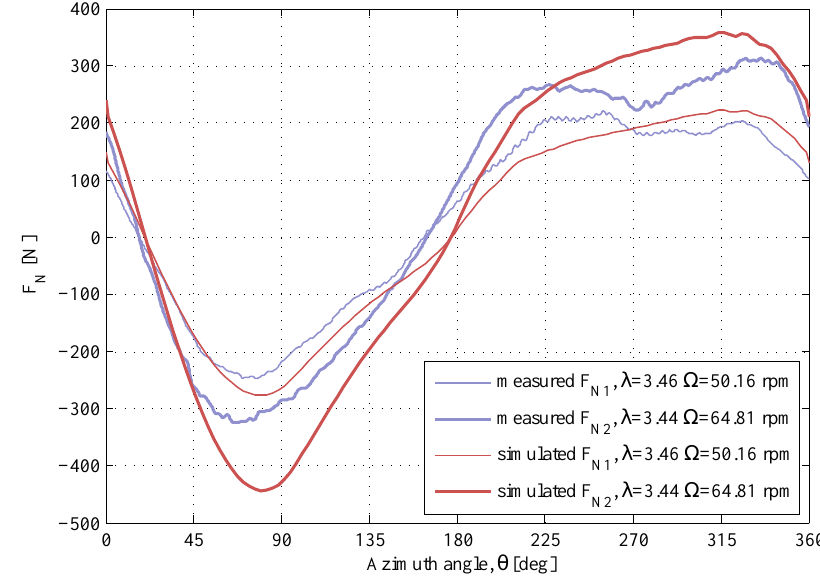
= 1 . 39 · 10 − 5 m 2 / s , 1